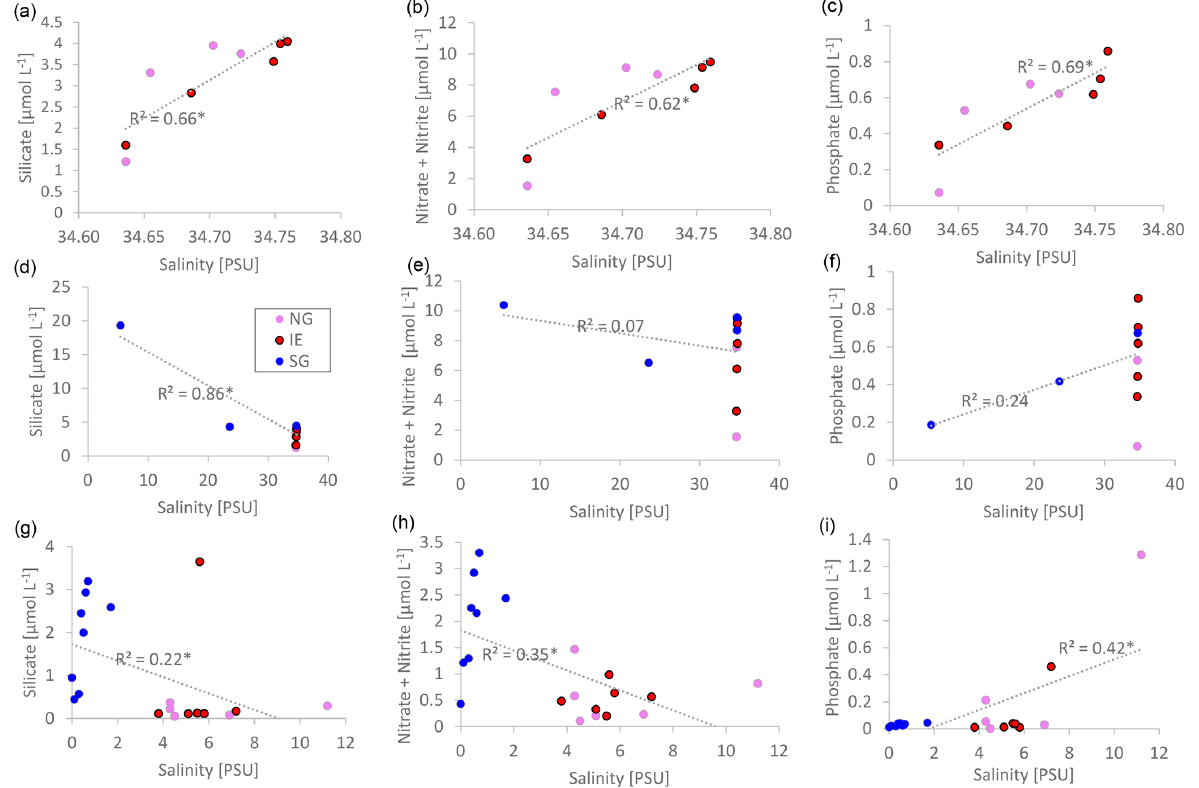
Figure 5. Linear salinity–nutrient correlations of NG and IE water samples (a–c) ; NG, IE, and SG water stations (d–f) ; and sea ice samples of NG, IE, and SG (bulk salinities) (g–i) . A higher concentration in saline Atlantic water is shown as a positive correlation, and a higher concentration in glacial meltwater is shown as a negative correlation. Significant correlations ( p < 0 . 05) are marked with an asterisk beside the R 2